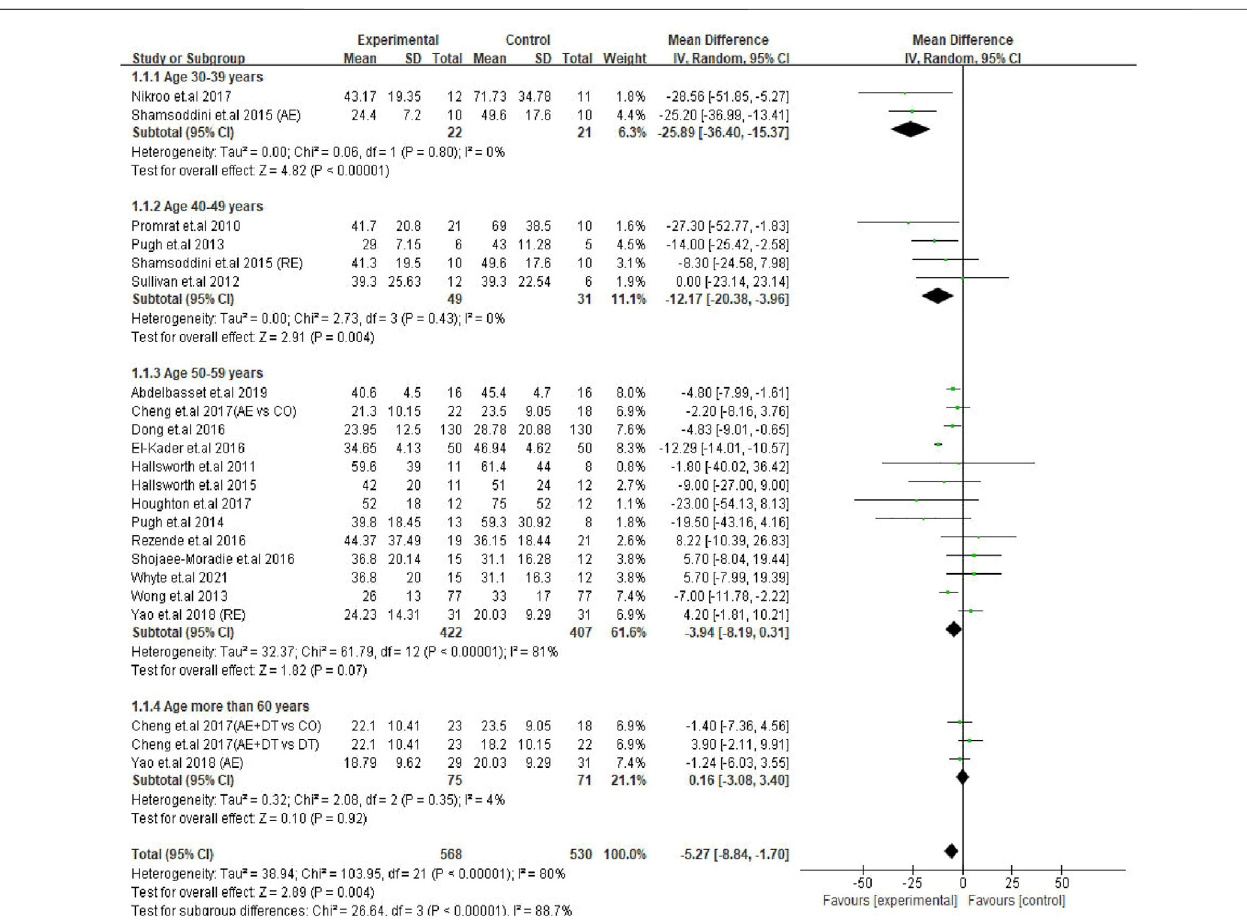
FIGURE4| SubgroupanalysisofexerciseinterventiononchangesinALTlevelsindifferentagegroupsofNAFLD/NASH patients.SD,standarddeviation;95%CI, 95% con fi dence interval.